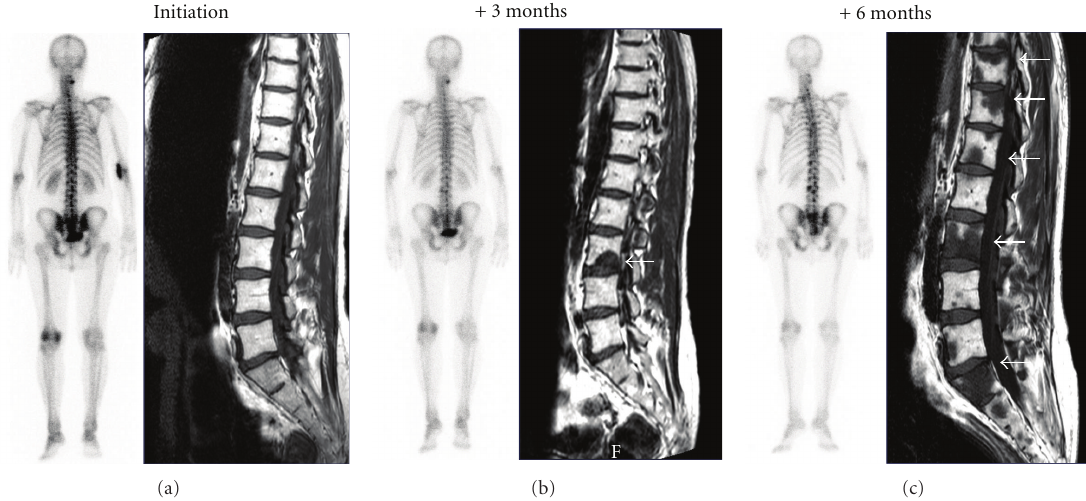
Figure 2: Consecutive series of three 99m Tc bone scans (BS) and MRI acquired three months apart on a patient included in a clinical trial designed for M0 CRPC. Only the third BS is adjudicated as positive by the central review although he was already progressive on MRI at the second metastatic